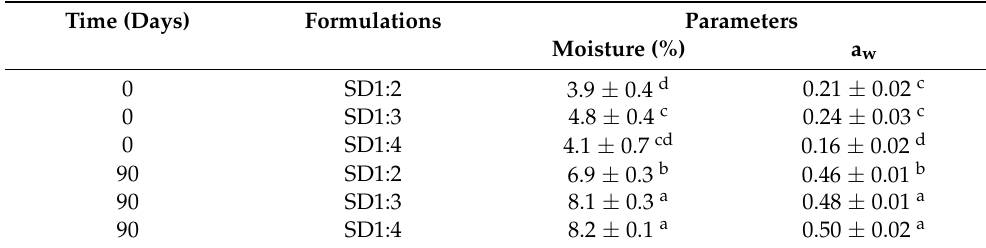
Table 5. Moisture and water activity (a w ) of encapsulated carotenoid-rich guaran á peel extract. Time (Days) Formulations Parameters Moisture (%) a w 0 SD1:2